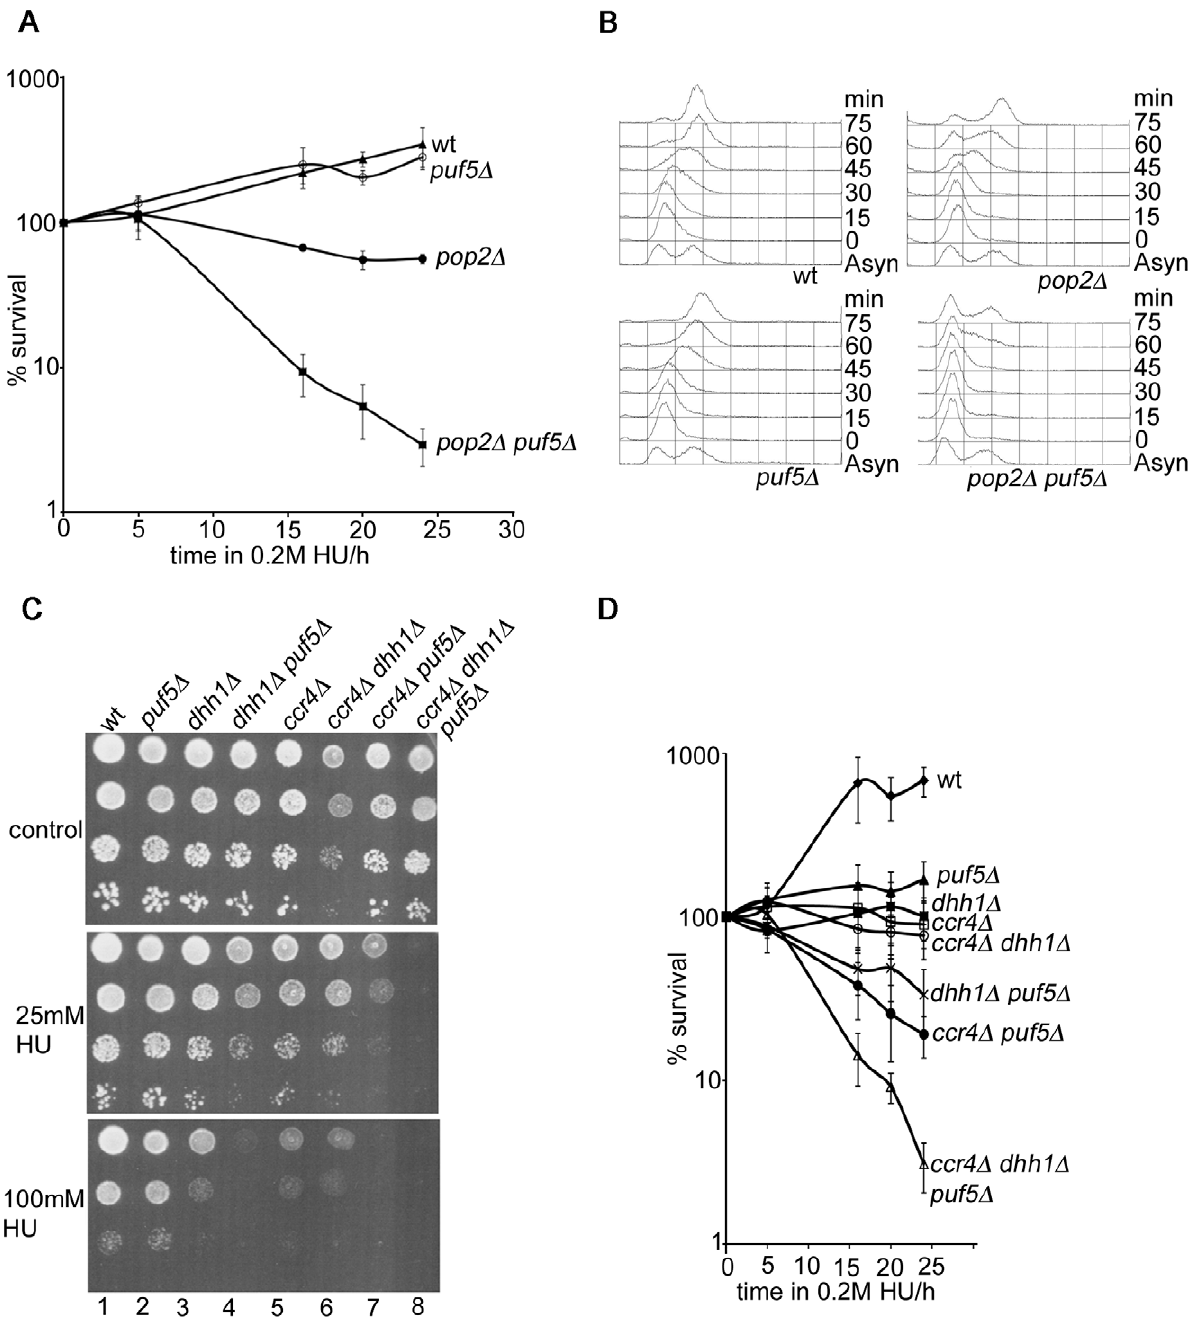
Figure 1. Puf5 has Pop2-independent roles in response to HU. A) Time course experiments were performed in 0.2 M HU. Shown are averages from three independent cultures and the standard deviation. B) Cells were processed for FACS analysis as described in Materials and Methods. C) Cells of the indicated strains were dropped on plates with or without HU and photographed after 3 days at 30 u C. D) Time course experiments were performed as in A). Shown are averages of at least six independent colonies for each strain. The error bar is the standard deviation.